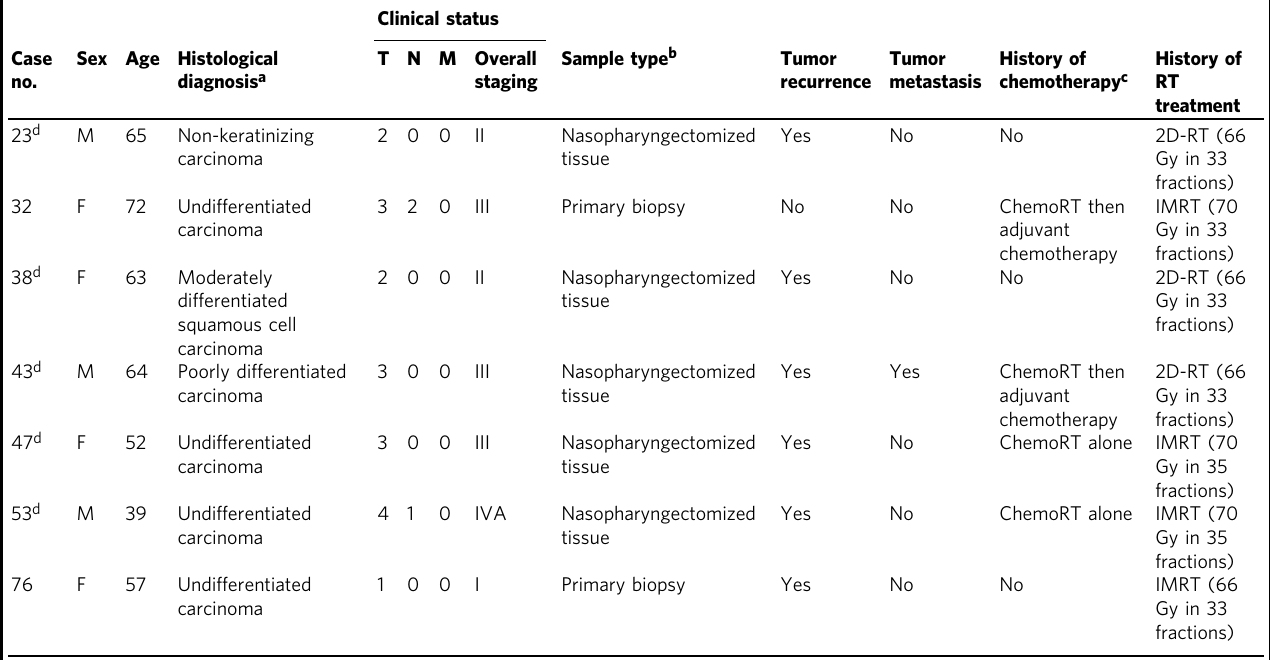
Table 1 Clinical data of donor patients